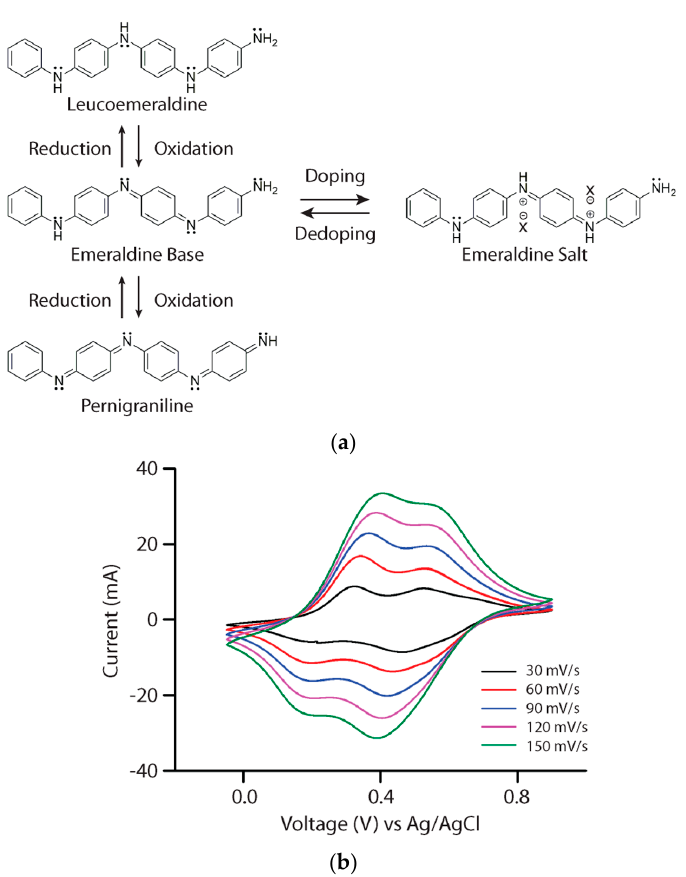
Figure 1. ( a ) Structures exhibiting the redox chemistry and doping properties of aniline tetramer; ( b ) cyclic voltammetry (CV) measurements on aniline tetramer film in a three-electrode configuration as a function of scan rate.